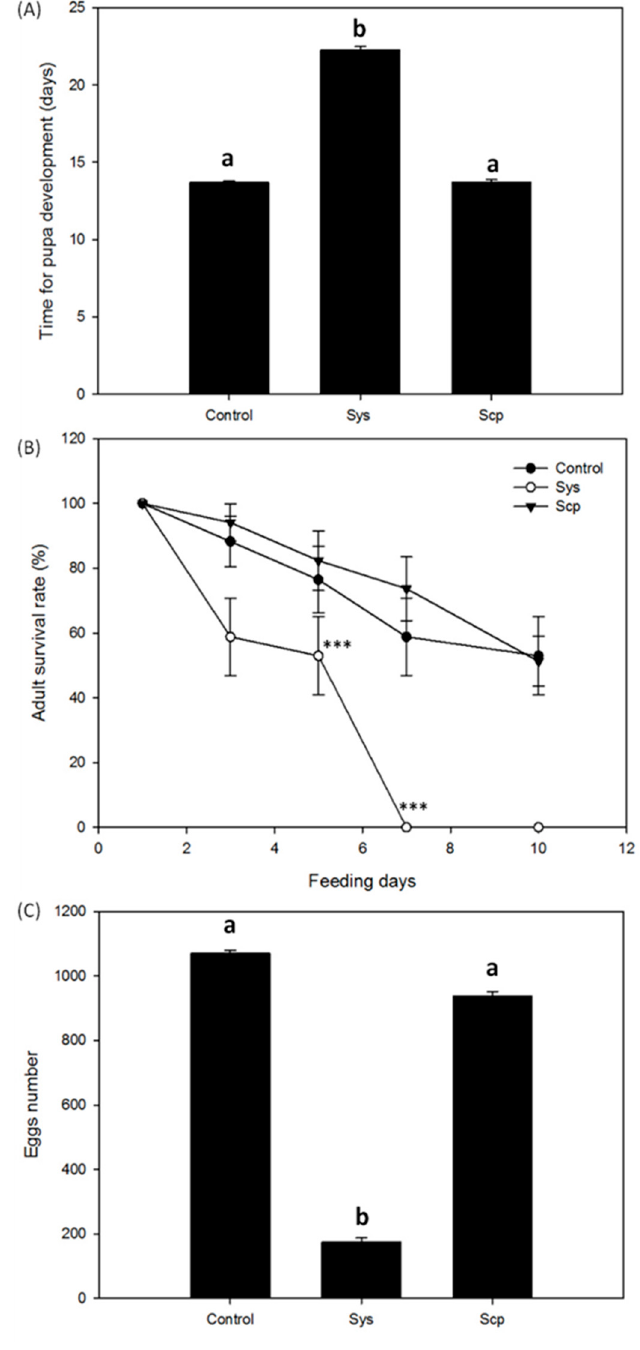
Figure 3. Systemin e ff ect on development and reproduction of Spodoptera littoralis larvae. Tomato plants supplied with 100 pM Sys, or 100 pM Scp or PBS1X in hydroponics were used to feed S. littoralis larvae, on which the following parameters were scored: duration of pupal development ( A ), adult survival rate ( B ) and number of laid eggs ( C ). Letters and asterisks denote statistically significant di ff erences (*** p < 0.001; one-way ANOVA). A group of 32 larvae was used for each experimental condition and the experiment was repeated twice.